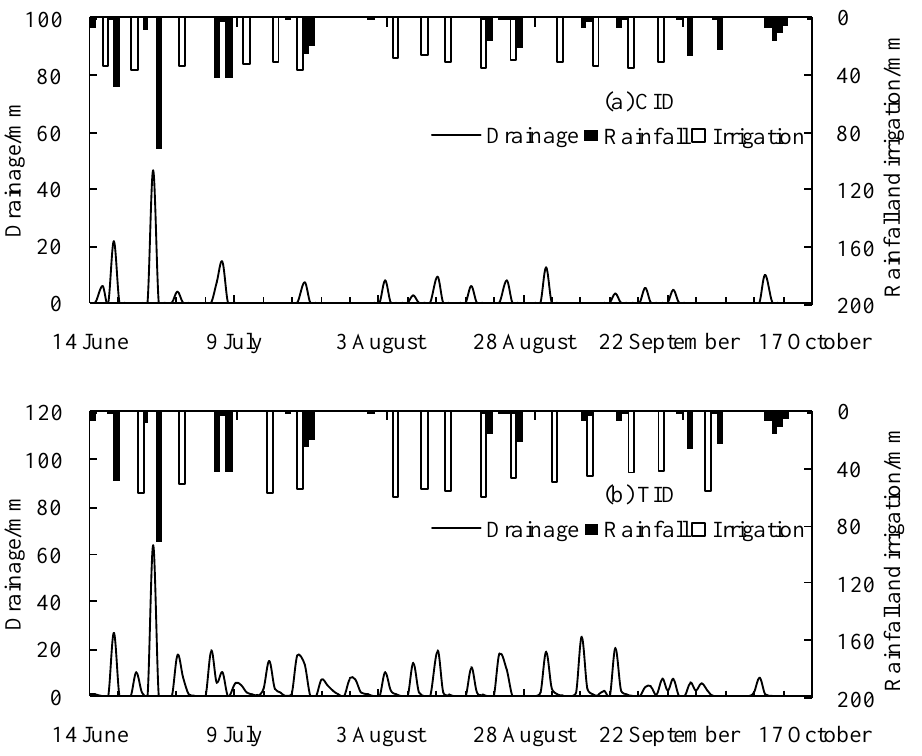
Figure 5. Typical daily rainfall, irrigation and drainage. ( a ) Controlled irrigation and drainage (CID) mode and ( b ) the traditional irrigation and drainage (TID) mode.